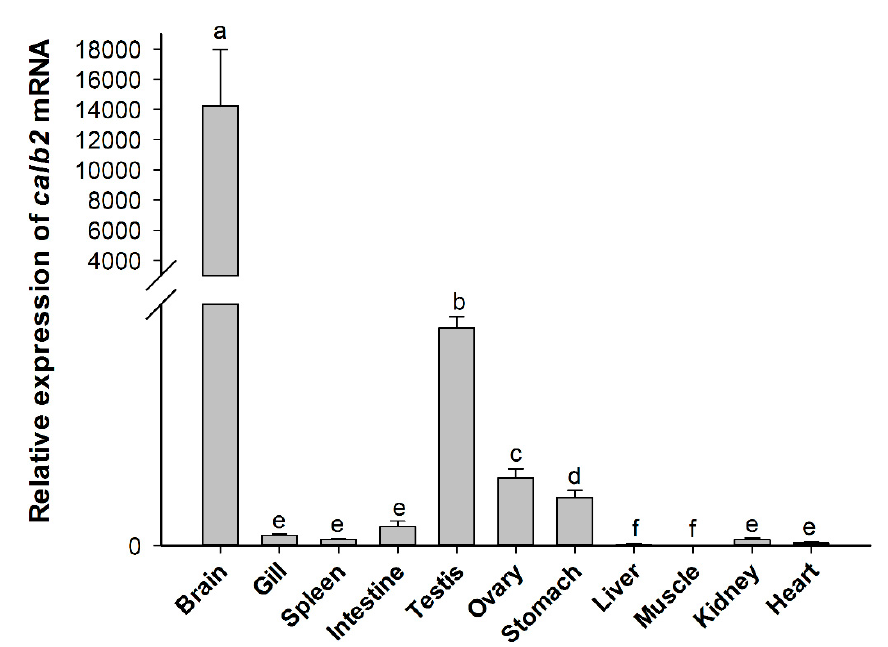
Figure 5. Relative expression levels of calb 2 mRNA in different tissues from P. olivaceus . Each gene was calculated based on the level of expression in the liver. The different alphabetic symbols represent statistically significant differences ( P < 0.05).